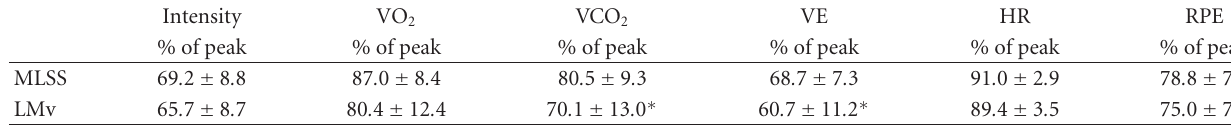
Table 2: General results corresponding to maximal lactate steady-state intensity (MLSS), lactate minimum, relative to peak variables. Intensity; VO 2 : oxygen uptake; VCO 2 : carbon dioxide output; VE: minute ventilation; HR: heart rate; RPE: rate of perceived exertion.